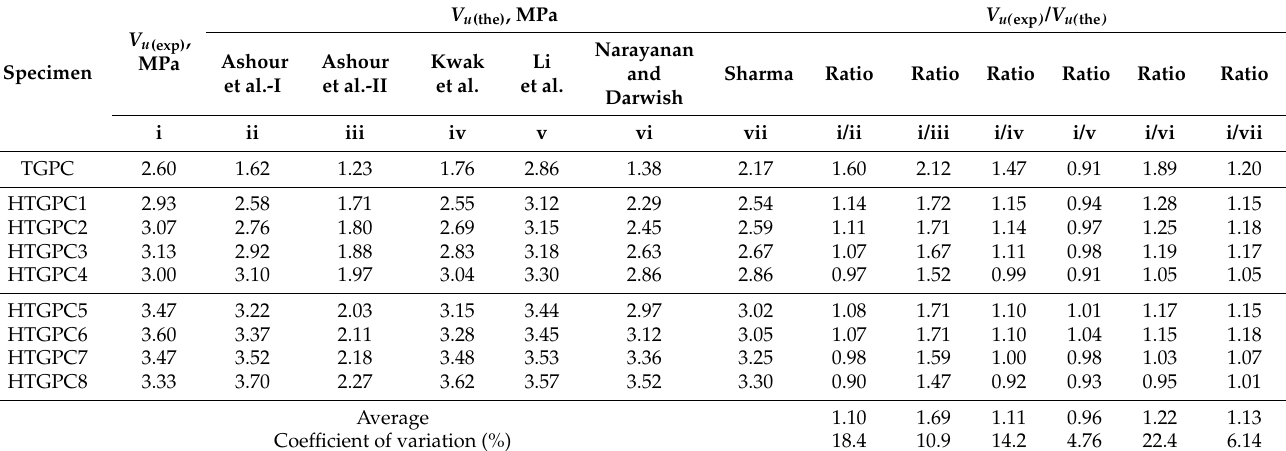
Table 4. Comparison of experimental values with theoretical values obtained from the literature.